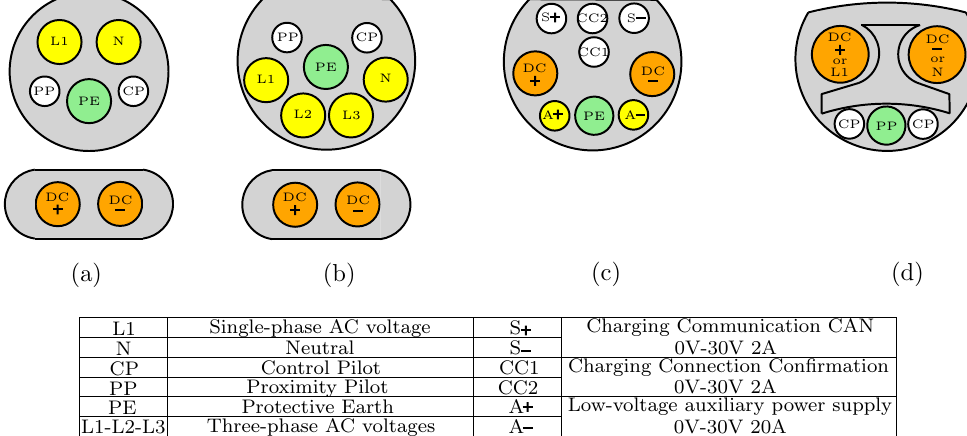
Figure 3. Examples of EV connectors : ( a ) SAE J1772 (Type 1); ( b ) SAE J3068/EU (Type 2); ( c ) BB (GB/T 20234.3); ( d ) Tesla (Ultra-fast